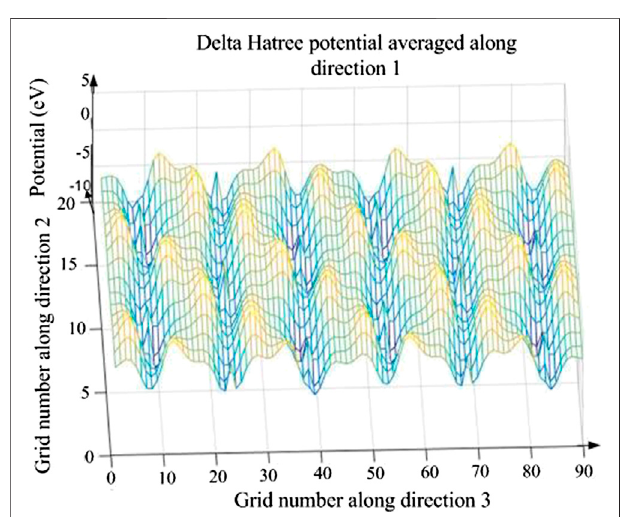
of Figure 1 , 4 × 3 × 2 supercell model is built. Virtual atomic mixing can speed up the calculation and meet the precision requirements. The results of calculation of Li 1 − x Na x Ni 1/3 Co 1/ (cid:2) 0.01, 0.02, 0.03 ... 0.10) are analyzed in this 3 Mn 1/3 O 2 ( x